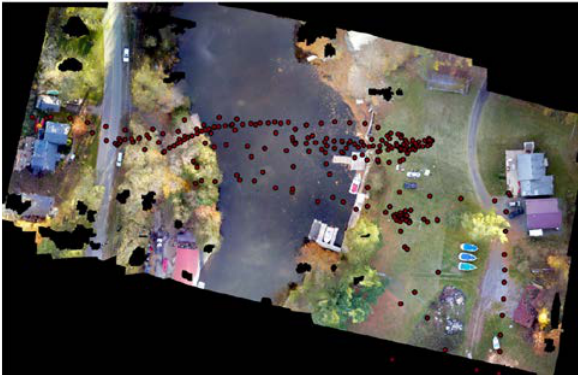
Figure 4. Orthoimage mosaic and camera locations.